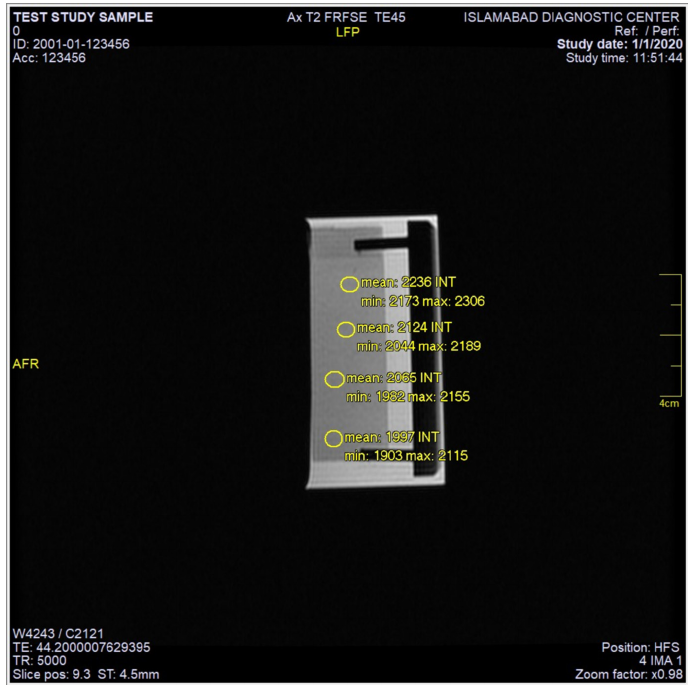
intensity values of region of interest (ROI) chosen in different sections of the film. The ROI